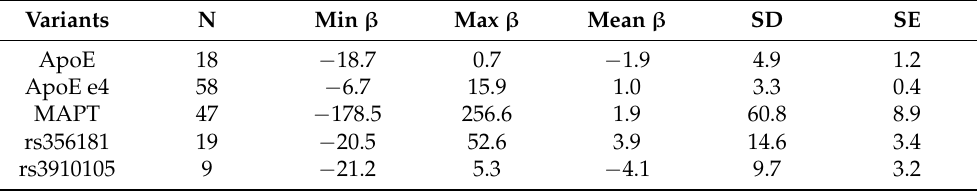
Table 1. The overview of the eQTL loci, number of transcripts and their effect sizes as β values for blood transcriptome. Explanation: Variants—variants under the study, N—number of statistically significant transcripts identified for particular variant, Min β —minimal β value, Max β —maximum β value, Mean β —mean β value, SD—standard deviation, SE—standard error of